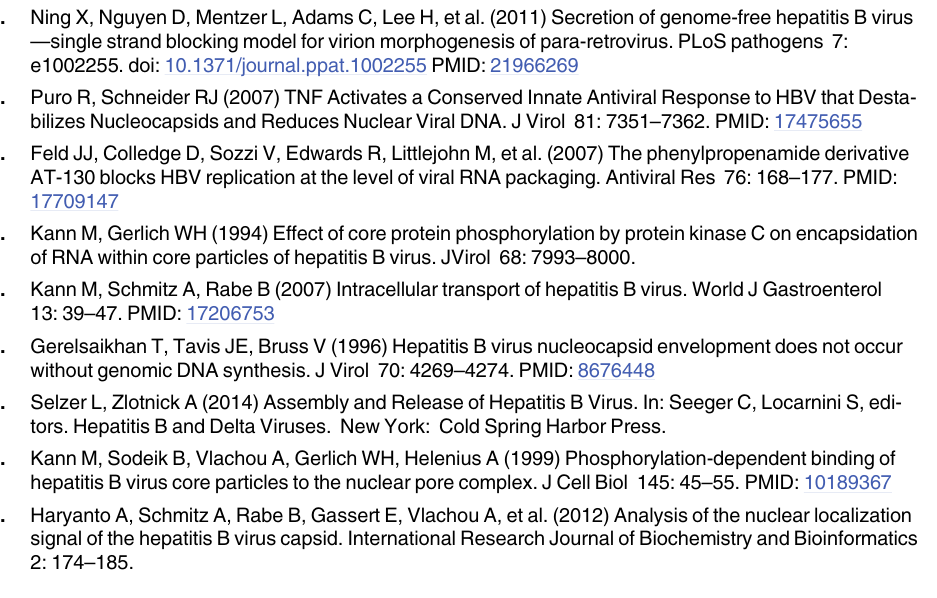
gauge the amount of space available. S6 Fig. Resolution estimation. The black (phosphorylated empty Cp183), green (phosphory- lated Cp183 with Imp β ) and red (Cp183 with Imp β ) curves show the FSC for the 3D recon- structions in Fig 3. The blue curves (thick, all particles; thin, dark particles) show the FSC for the 3D reconstruction in Fig 7. The gray curves (thick, all particles; thin, dark particles) show the FSC for the 3D reconstruction in Fig 8. The 3D reconstruction of the dark particles in NaCl was calculated using gold-standard FSC. S1 Table. Estimated Imp β : Capsid ratio determined from size exclusion chromatography. As SEC is not an equilibrium technique, Imp β can dissociate during the course of the 40 min- ute-long experiment. In addition, some capsid-Imp β complex may precipitate before or during chromatography. These complications result in an underestimate of capsid-bound Imp β . S2 Table. Data collection information. Data are presented for seven reconstructions of the full-length core protein Cp183 with and without Imp β